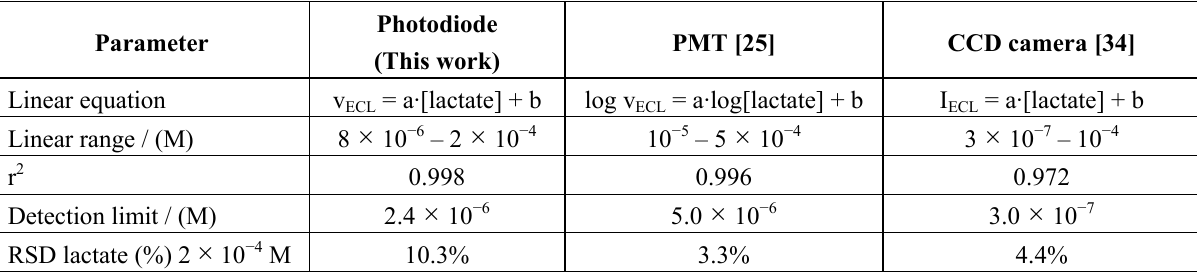
Table 2. Comparison of different detection instruments for lactate ECL on screen-printed graphite